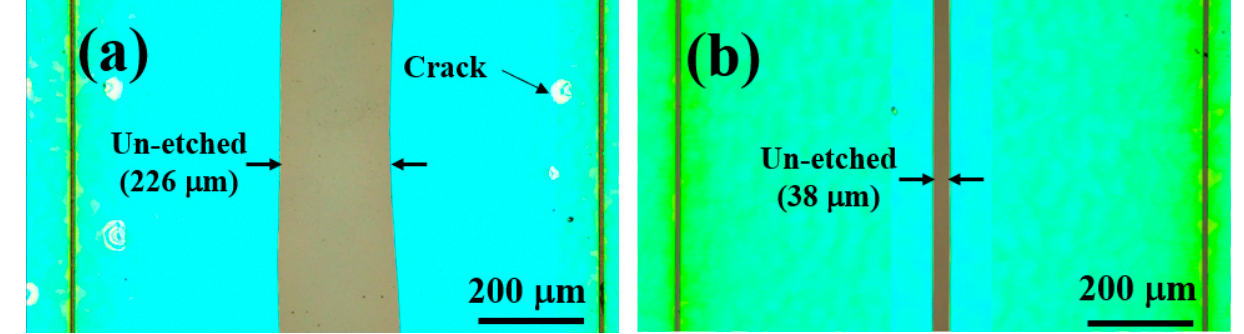
Figure 2. Plan ‐ view optical microscopy images of ( a ) Sample A and ( b ) Sample B after EC etching (scale bar = 200 mm). The spacing between two neighbouring trenches is 1 mm.